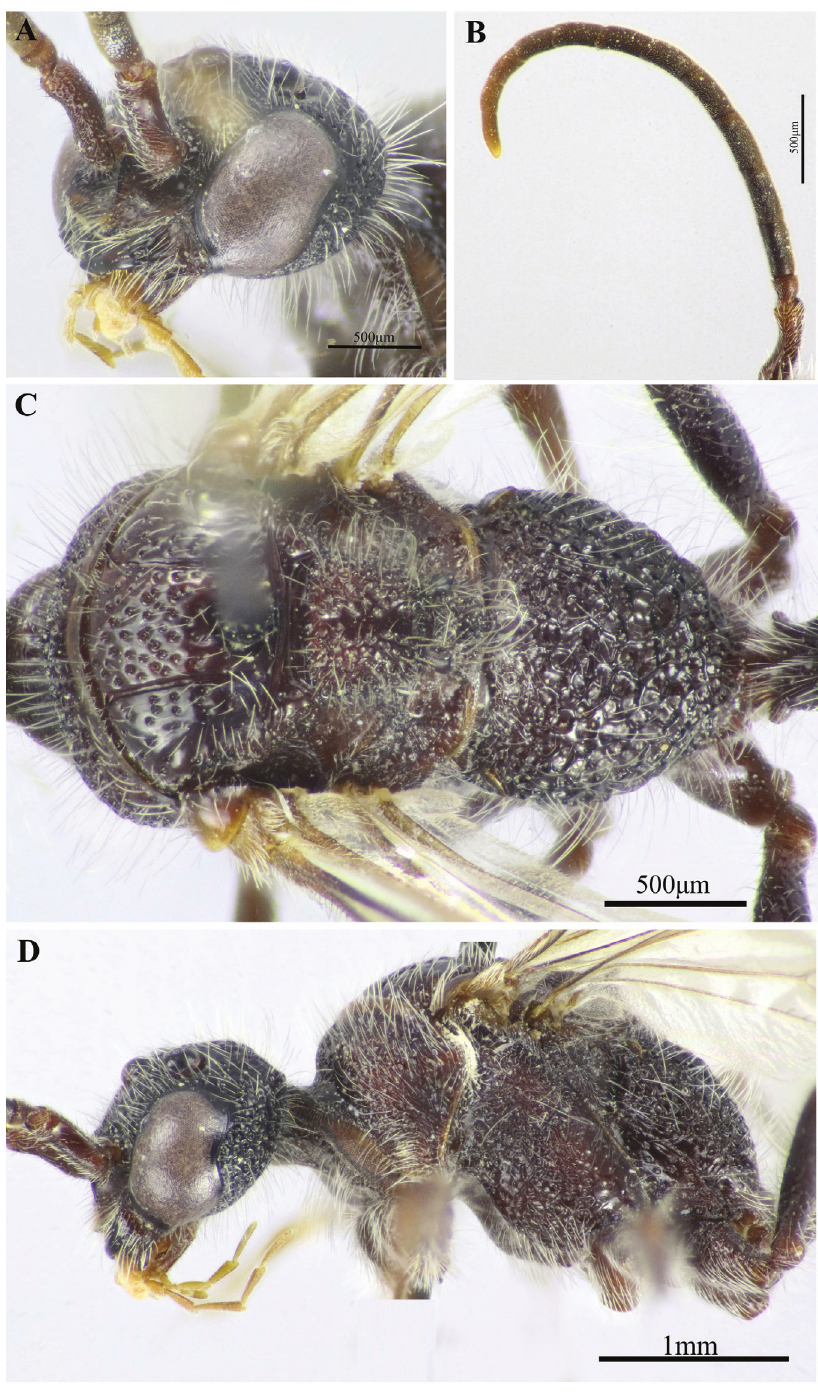
Figure 30. Pseudophotopsis subaurea sp. nov. (Male) A head, fronto-lateral view B antenna C mesosoma, dorsal view D head and mesosoma, lateral